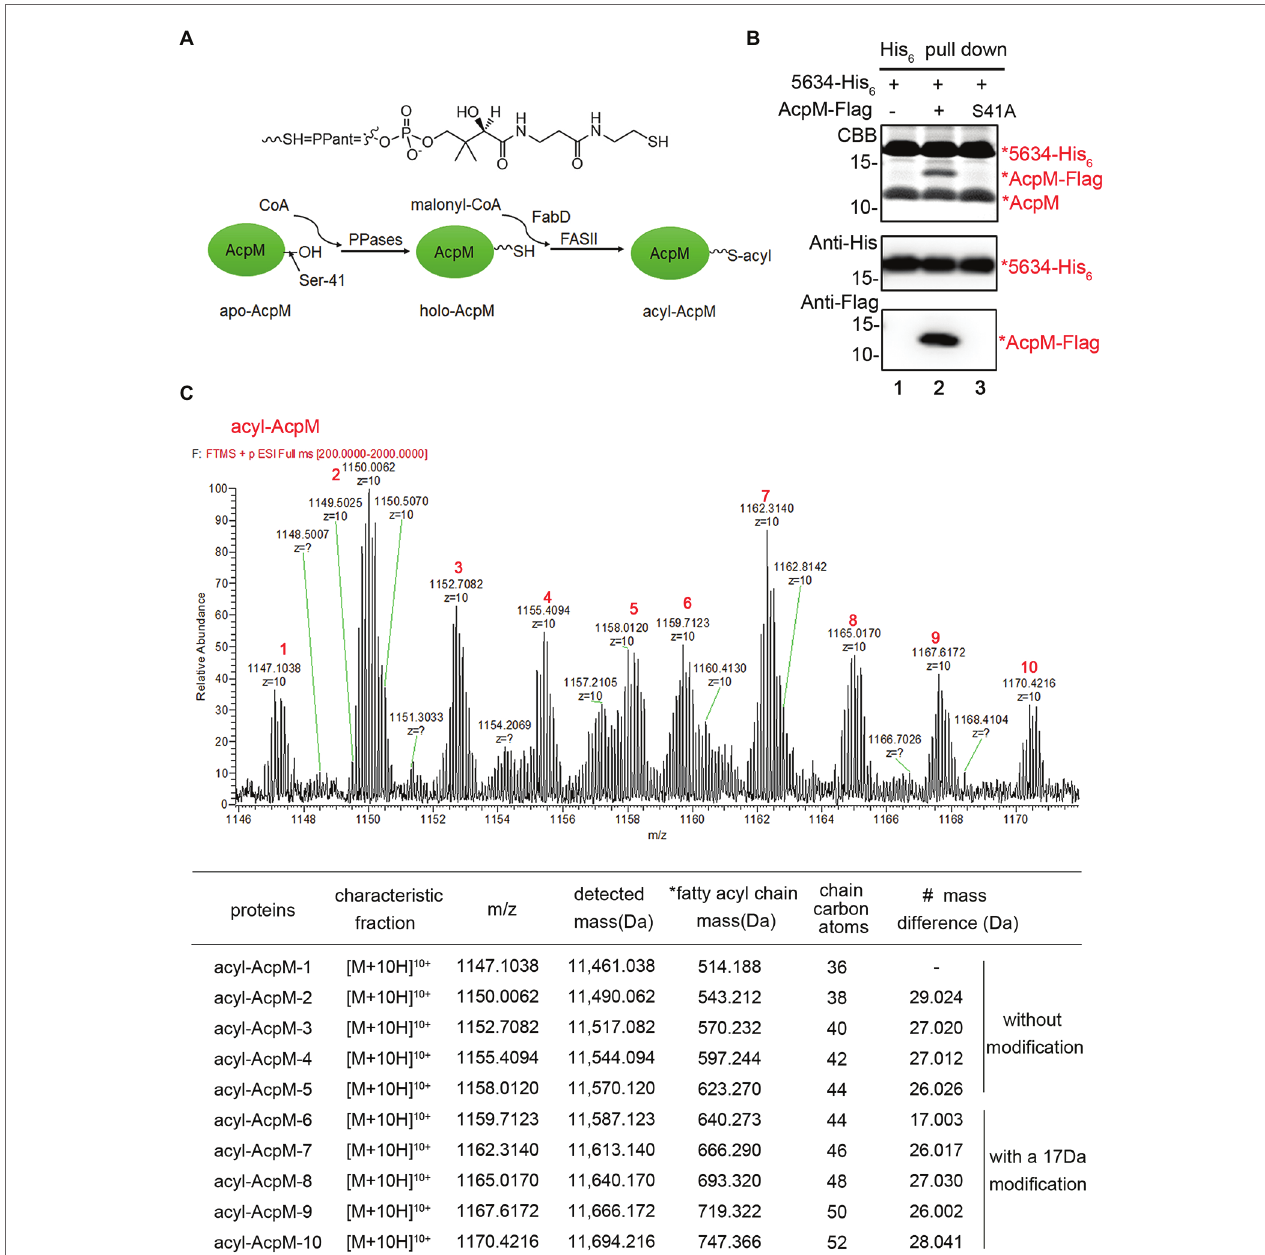
FIGURE 4 | MSMEG_5634 interacts with acyl-AcpM containing a long fatty acid chain. (A) Schematic diagram showing the formation process of acyl-AcpM. (B) MSMEG_5634-His 6 was coexpressed with AcpM-Flag (Lane 2) or AcpM (S41A)-Flag (Lane 3) in Mycobacterium smegmatis . MSMEG_5634-His 6 was purified by Ni 2+ -NTA affinity chromatography. The eluted proteins were collected and analyzed by Tricine-SDS-PAGE and Western blot. (C) Determination of the mass of acyl- AcpM interacting with MSMEG_5634-His 6 by UPLC-HR-MS. The detailed data are listed under the mass spectrometry. *Fatty acyl chain mass, the mass of the fatty acyl chain in acyl-AcpM which is calculated by subtracting the theoretical molecular weight of holo-AcpM 10,946.85 from the molecular weight of acyl-AcpM. # Mass difference, the increase in the mass of fatty acyl chain compared with the value in the above